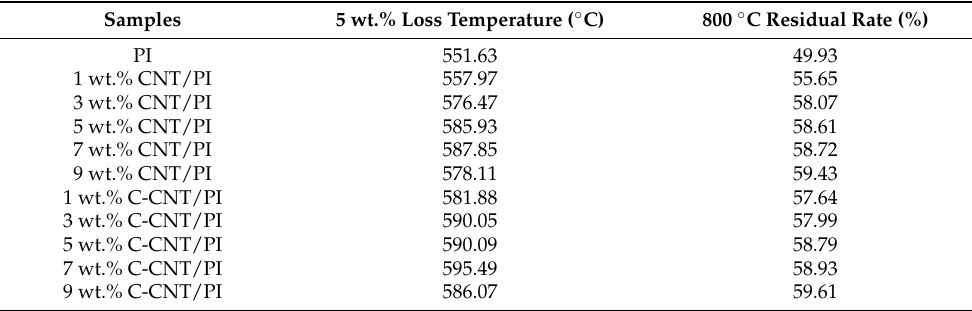
Table 5. The thermal properties of PI, CNT/PI and C-CNT/PI films.